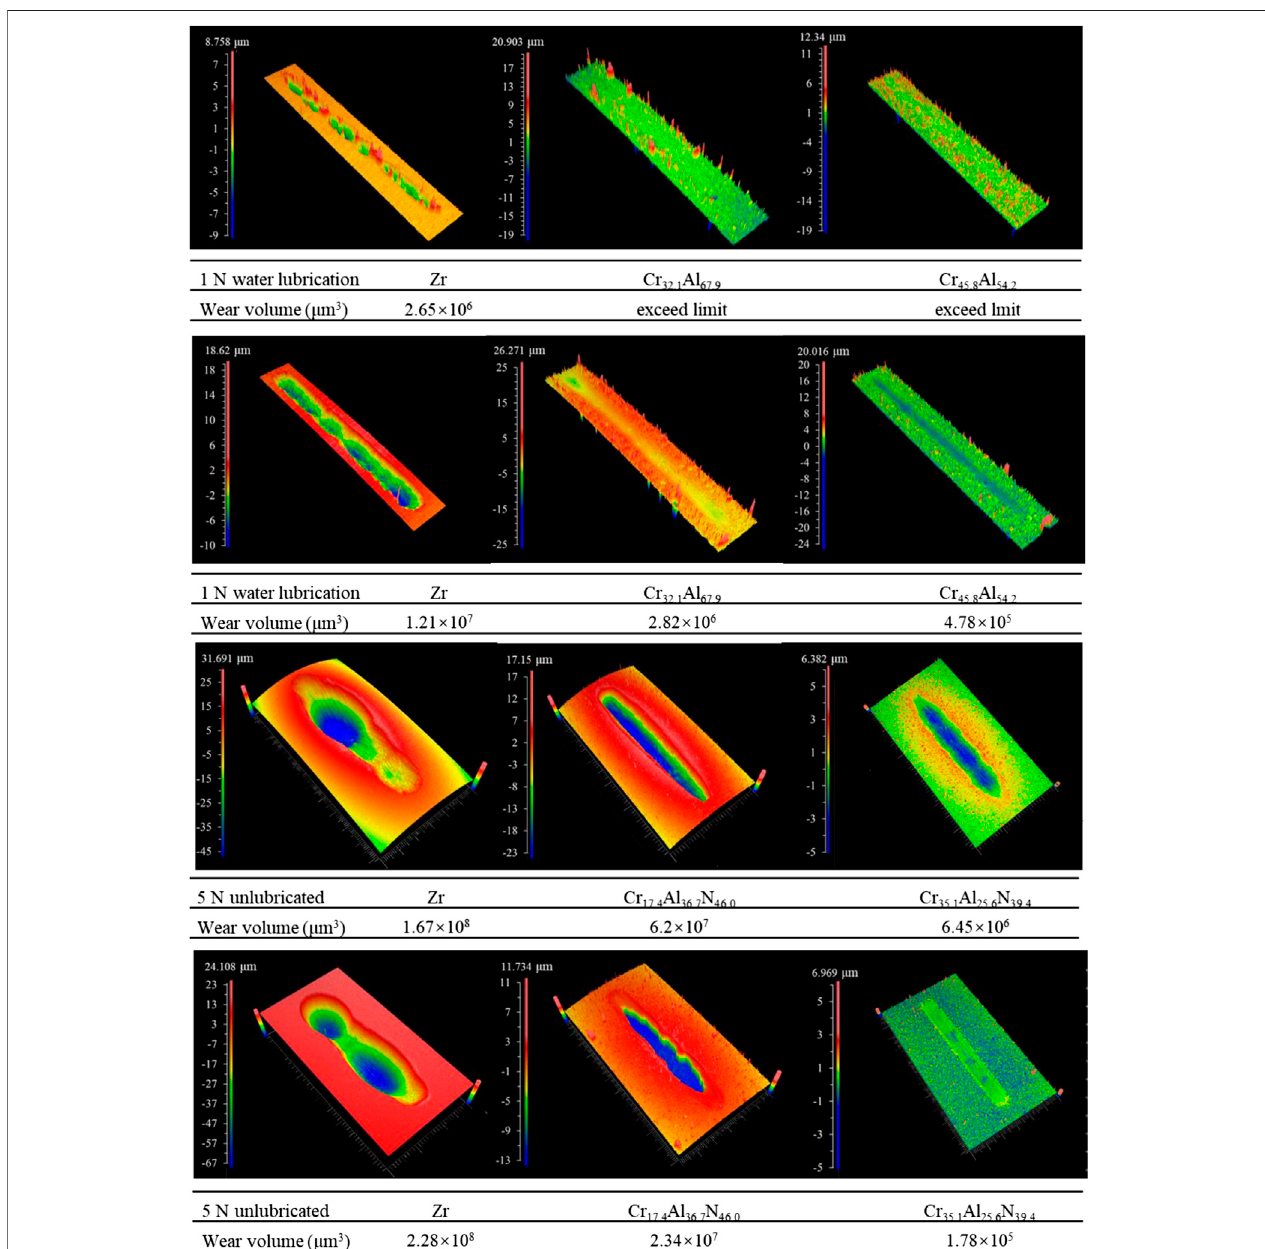
FIGURE 3 | Results of noncontact three-dimensional optical pro fi lometry under different